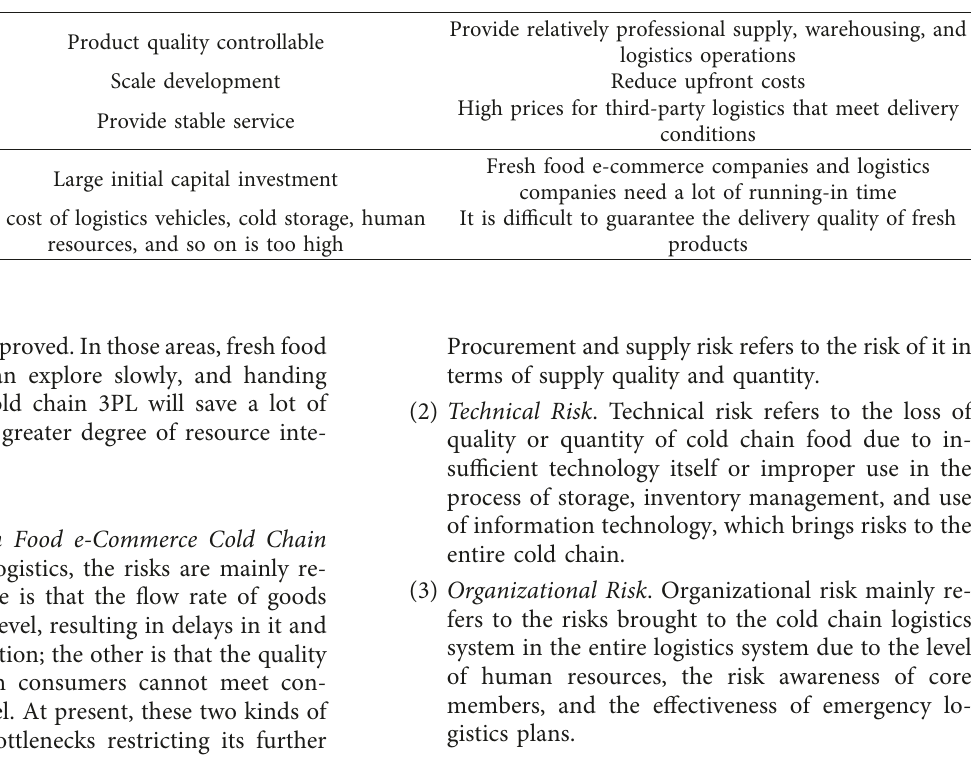
Table 2: Advantages and disadvantages of self-operated cold chain and third-party cold chain. Advantages